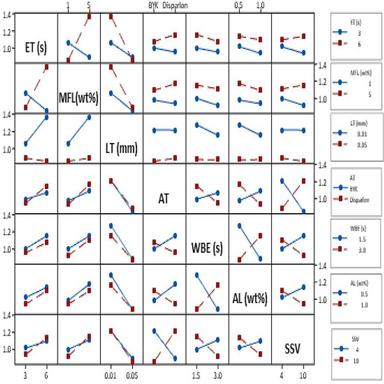
Thickness variation of 3D printed magnetic composite samples across six printing zones (as designated in) on the build head; Legend indicates experiment numbers 1 to 8 as indicated in 1; (Left) Experiment 1 to 4, (Right) Experiment 5 to 8.